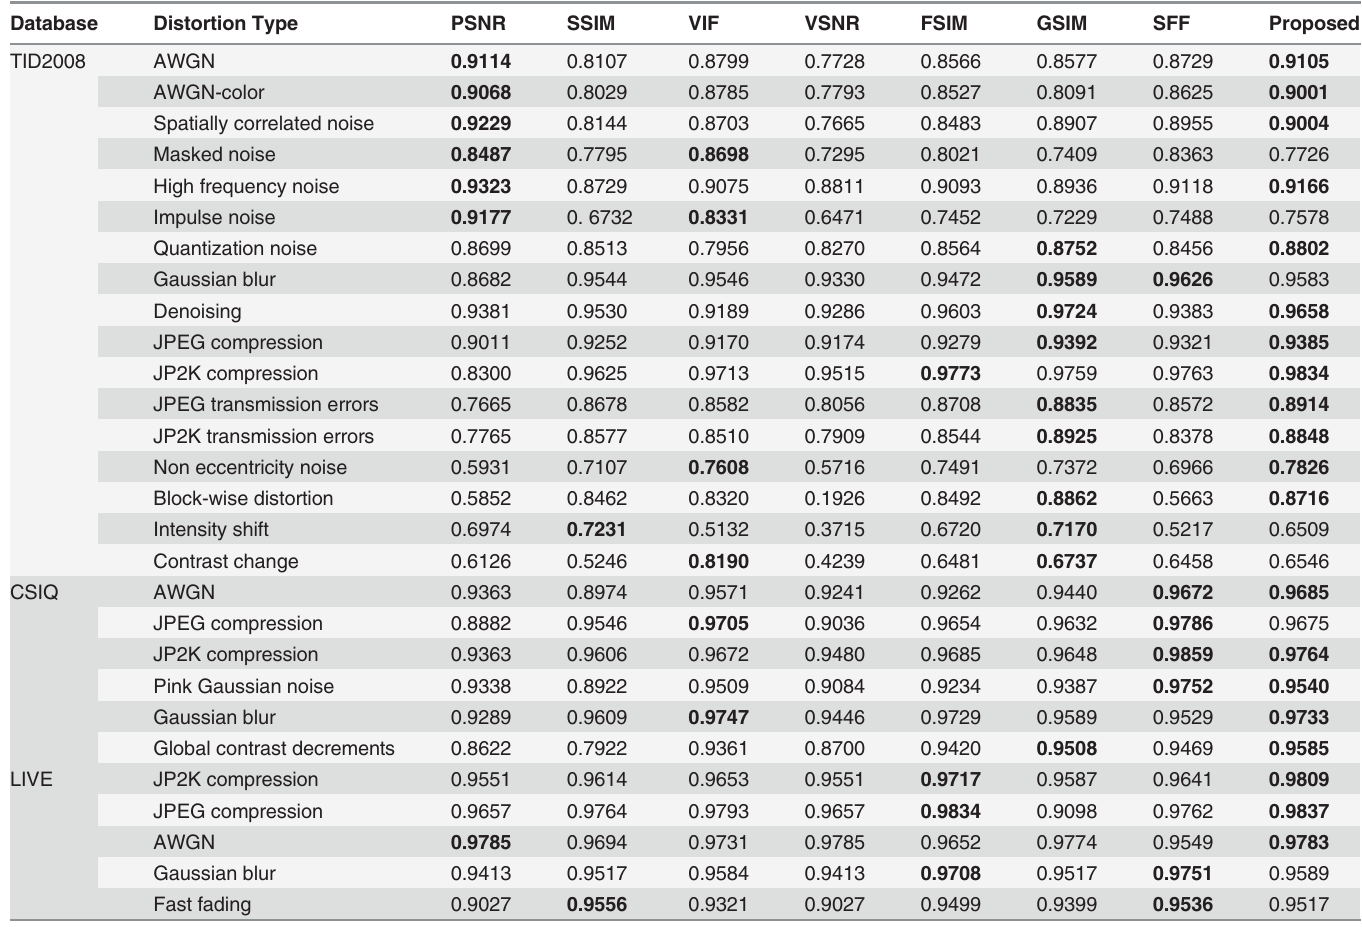
Table 6. SROCC values of IQA metrics for each distortion